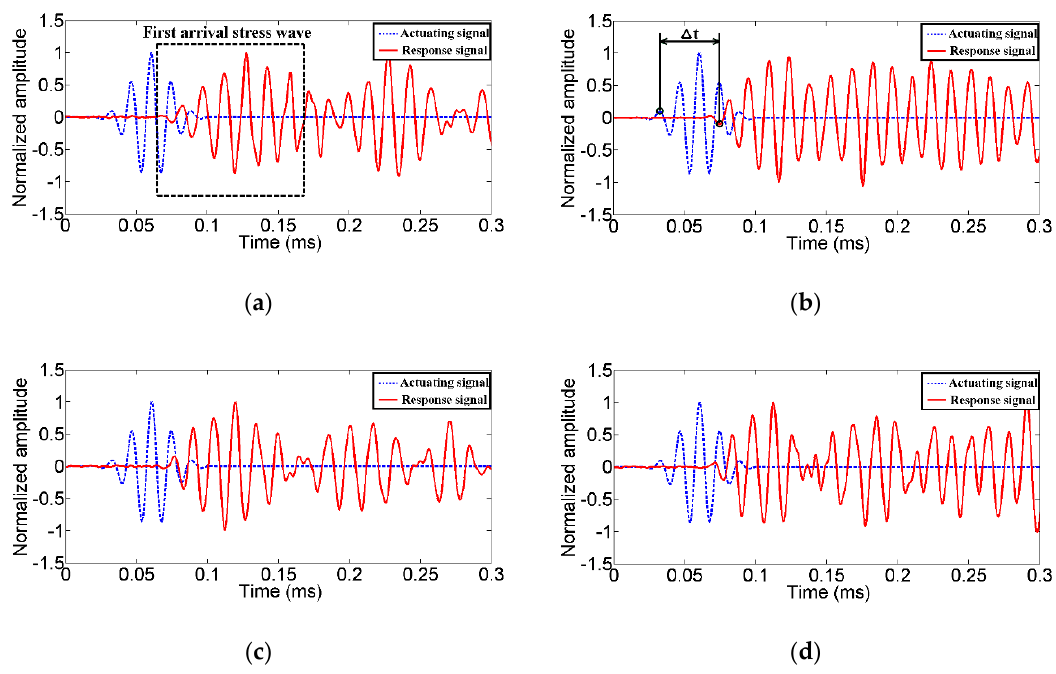
Figure 8. The time of arrival analysis when the TSA works as an actuator and ( a ) SA1 works as a sensor, ( b ) SA2 works as a sensor, ( c ) SA3 works as a sensor, ( d ) SA4 works as a sensor.